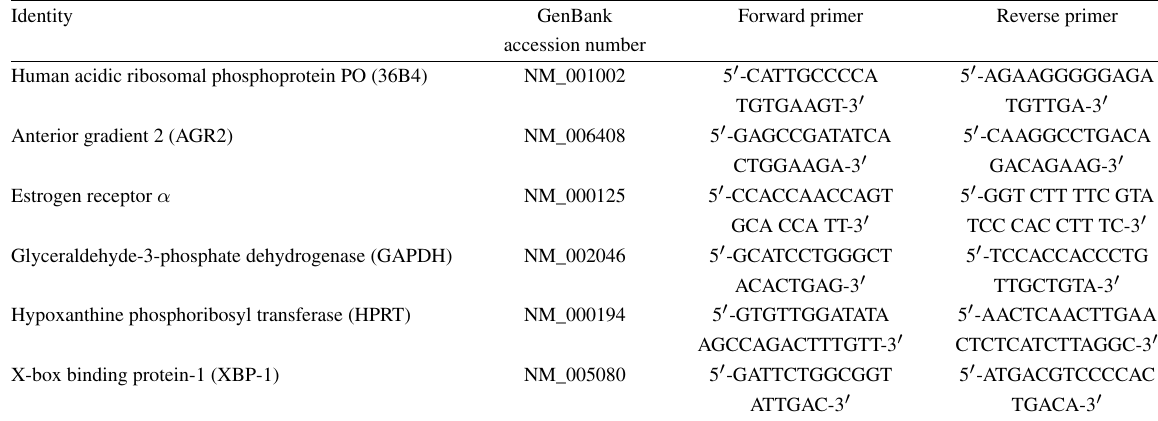
PCR primers used for quantitative